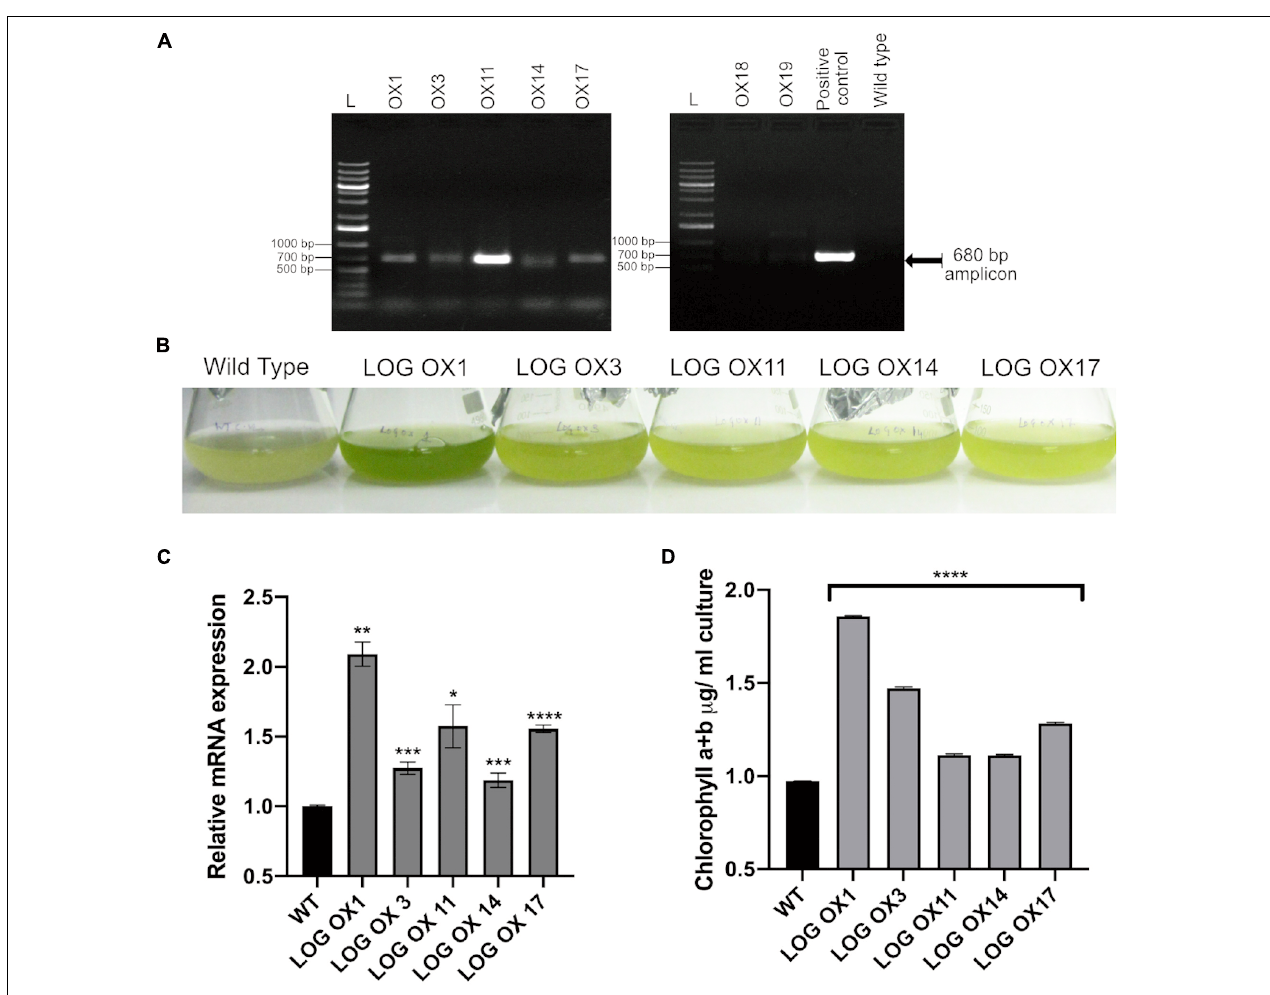
FIGURE 4 | Overexpression phenotype of the CvarLOG1. (A) Colony PCR confirmation of seven independent transgenic lines versus the wild type was compared to the positive control. An amplicon of size 680 bp was seen in all lines and positive control, faints bands were detected in lines OX18 and OX19. (B) LOG OX phenotype 30 dpi (days post inoculation) where all five independent OX lines have a stay-green phenotype and wild type has started senescing; LOG OX1 showed the best phenotype. (C) CvarLOG1 transcript accumulation in wild type and five independent OX lines during log phase as determined by qPCR; bars indicate ± SE ( n = 3). (D) Chlorophyll content of WT and five independent LOG OX cultures at 30 dpi; bars indicate ± SE ( n = 3). For all graphs, data were significant at **** P ≤ 0.0001, *** P ≤ 0.001, ** P ≤ 0.01, and * P ≤ 0.05 compared with the wild type using Student’s t